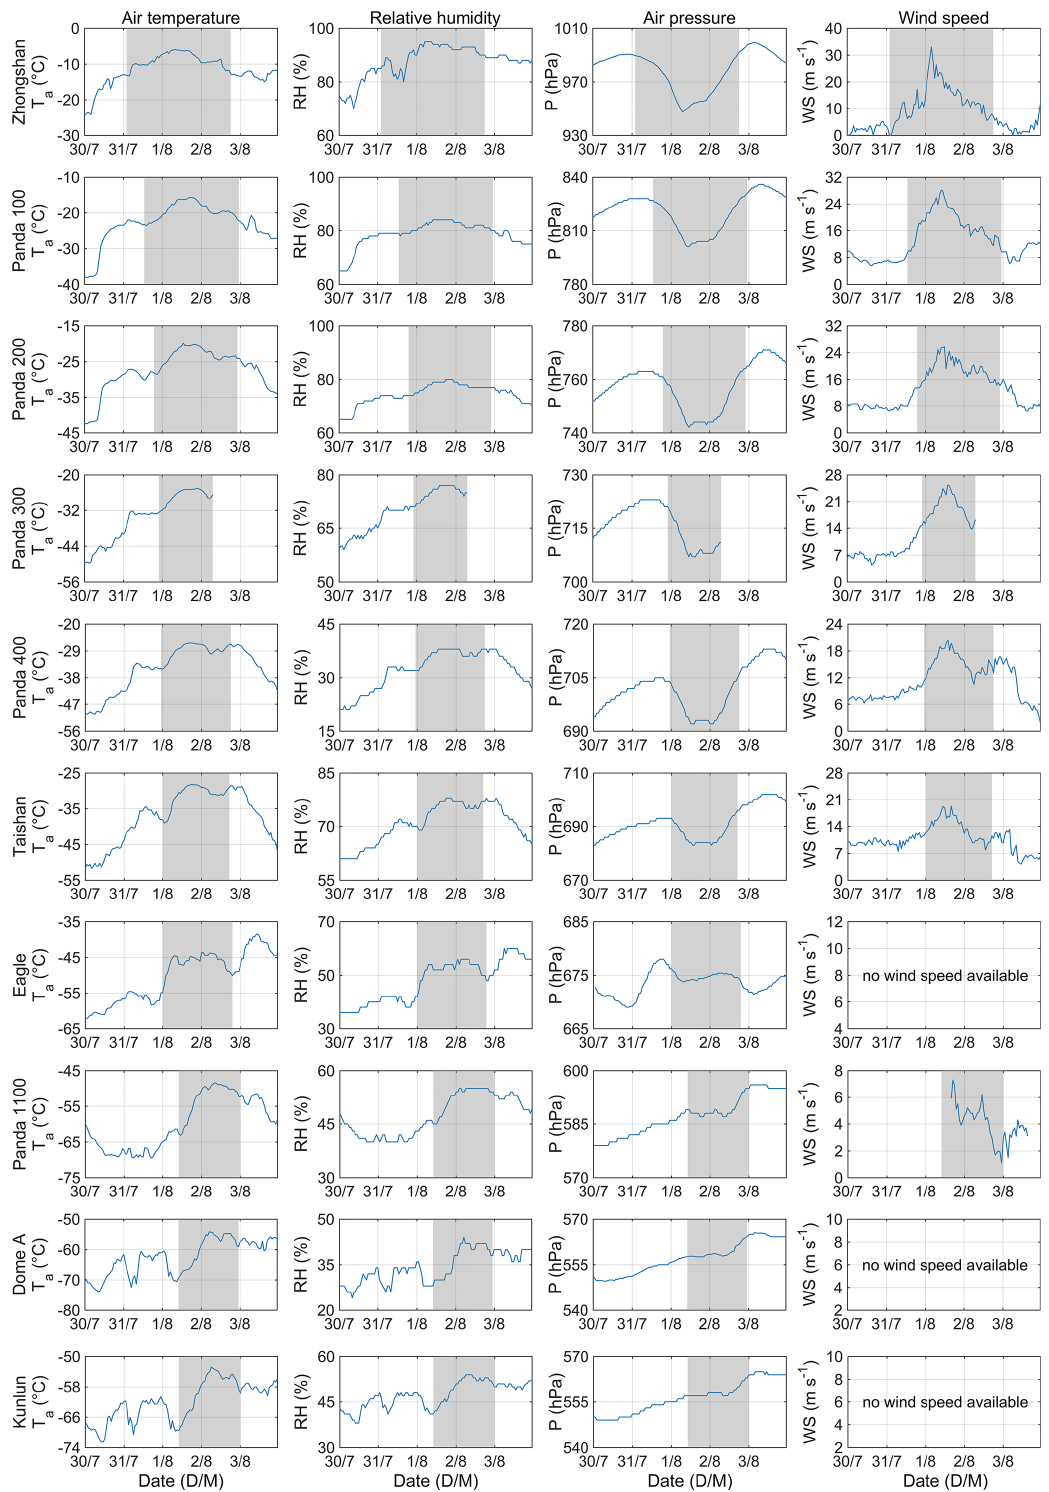
Figure 12. Time series of air temperature, relative humidity, air pressure and wind speed at AWSs of the PANDA network (except Panda S) from 00:00 30 July to 23:00 on 3 August 2020 (UTC); gray zone: blocking event.